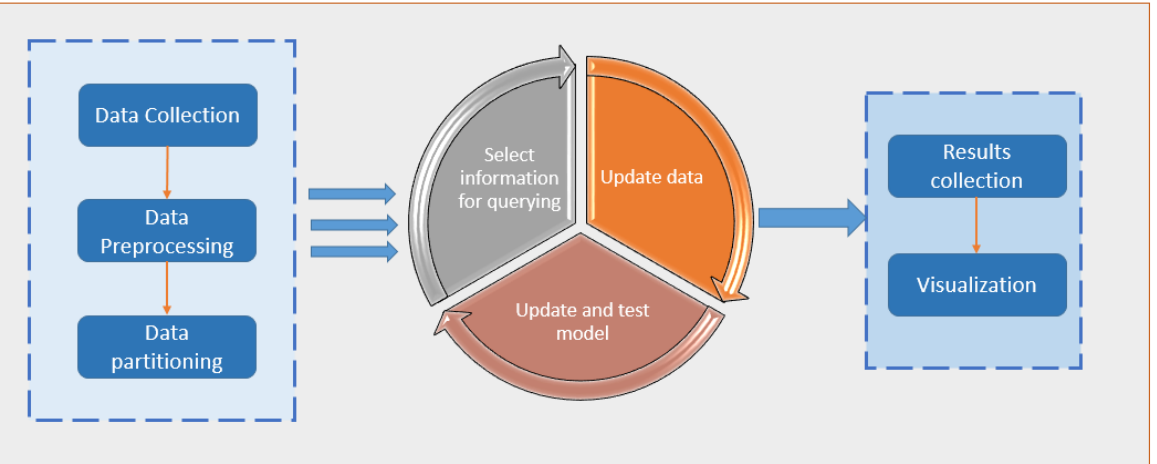
Figure 1. A general framework for implementing an active learning approach.